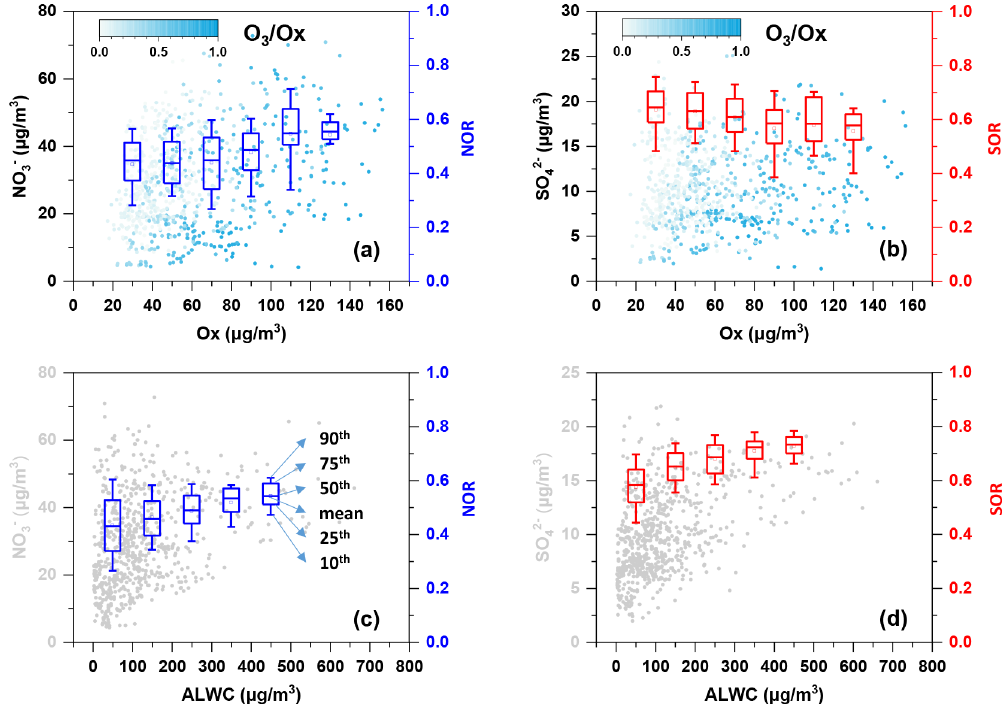
Figure 4. Variation of (a, c) nitrate and NOR and (b, d) sulfate and SOR as O x /ALWC increases. The data of NOR and SOR were grouped into different bins according to a 20µgm − 3 increment of O x in (a) and (b) and a 100µgm − 3 increment of ALWC in (c) and (d) . The colour scale represents O 3 / O x ratios in (a) and (b) . The mean (square), 50th (horizontal line inside the box), 25th and 75th percentiles (lower and upper box), and 10th and 90th percentiles (lower and upper whiskers) of the box chart are marked in (c) . The concentration of ALWC was simulated using the ISORROPIA-II